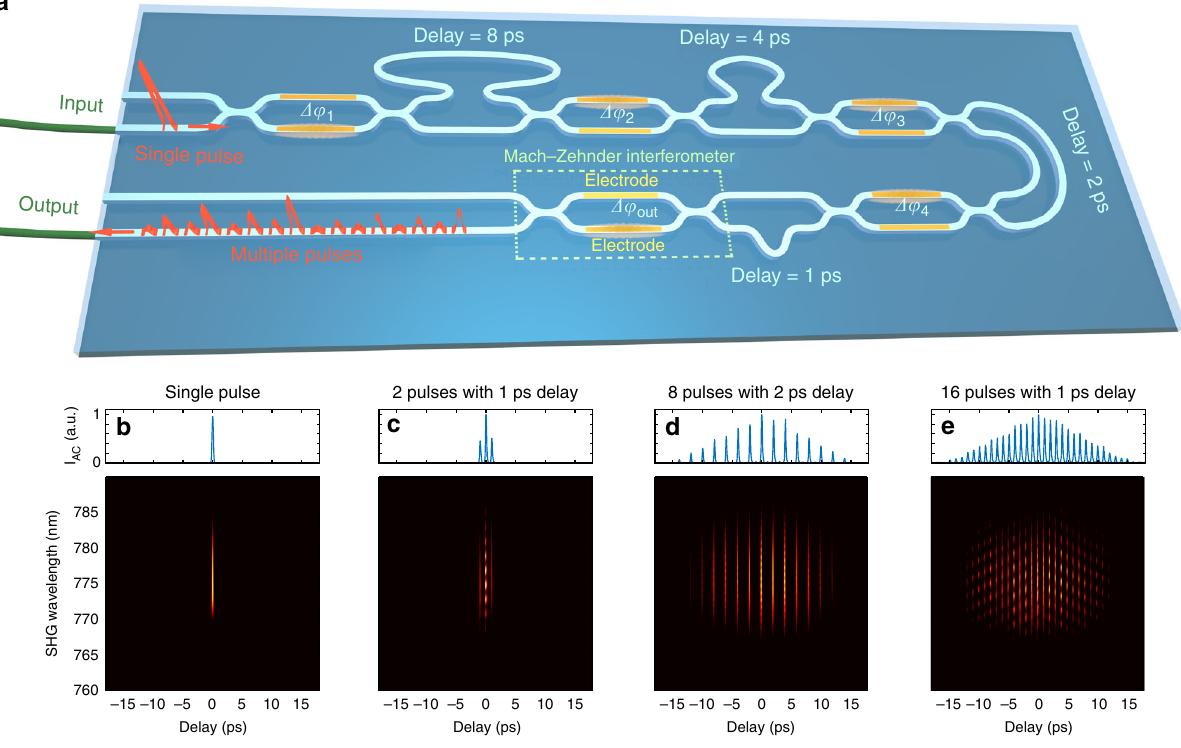
Fig. 2 Operational principle of the on-chip optical pulse-splitter. a Schematic diagram: The sample comprises cascaded Mach-Zehnder interferometers (MZI) and different delay lines made of high-refractive-index silica glass (white) — see Methods for details. Adjustable splitting and routing of the optical pulses into the various waveguide paths can be controlled by tuning each MZI arm phase difference Δφ N (where N is the interferometer number) via a refractive index change, thermally-induced using electrodes (yellow). We show in the fi gure a diagram comprising four interferometers used to adjust the relative splitting of pulses into the two arms of the subsequent unbalanced waveguide section. The last interferometer ( Δφ out ) is used to recombine the train of delayed pulses and regulate the overall output power. b – e Examples of generated optical pulse patterns characterized using intensity autocorrelation (AC — top) and frequency-resolved optical gating (FROG — bottom) measurements 53 . Multiple pulses (up to 16), featured by equal power but different pulse-to-pulse separation (as low as 1 ps), were obtained by setting each of the N = 4 interferometers to prede fi ned splitting conditions, in order to sequentially split and interleave pulse trains with variable relative delays. These simple pulse pattern examples were achieved by setting each MZI relative phase difference to one of three speci fi c values only: Δφ N = 0, so that the incoming signal (i.e. pulse or train of pulses) entirely propagates within the short arm of the unbalanced waveguide section; Δφ N = π , so that the incoming signal entirely propagates within the long arm of the unbalanced waveguide section; Δφ N = ± π /2, so that the incoming signal is equally split between the two arms of the unbalanced waveguide section (leading to a relative delay corresponding to the unbalance between these two arms). Parameters: Δφ 1 – 4 = 0 for ( b ); Δφ 1 – 3 = 0 and Δφ 4 = π /2 for ( c ); Δφ 1 – 3 = π /2 and Δφ = 0 for ( d ); Δφ = π /2 for ( e 4 1 – 4